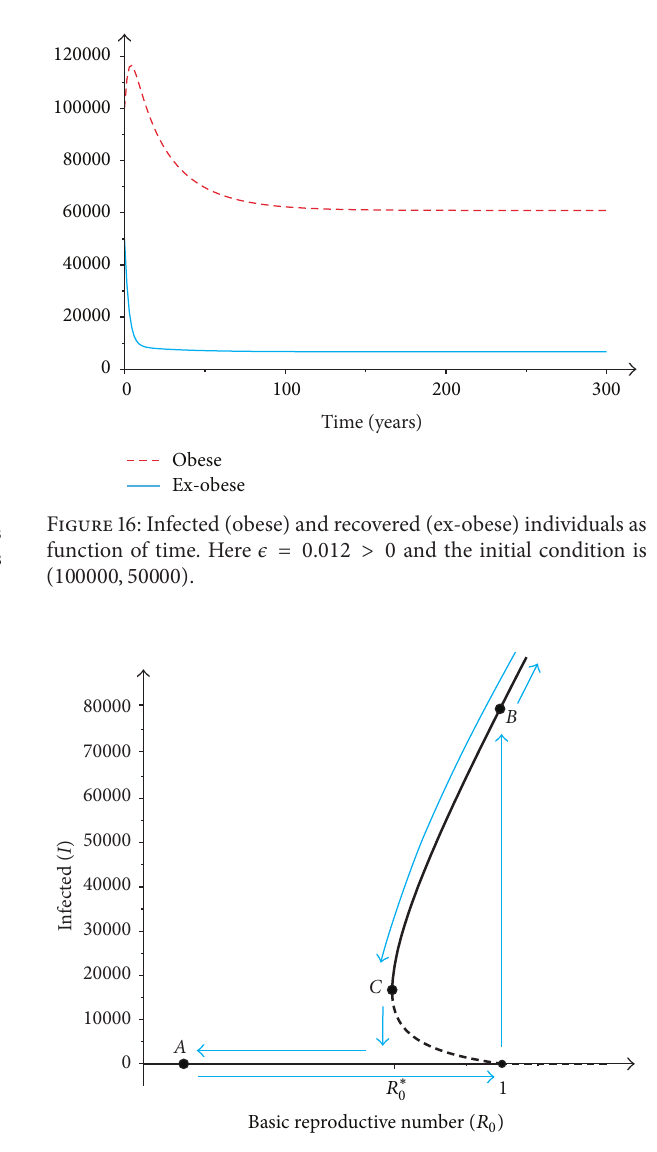
Figure 17: Schematic representation of hysteresis phenomenon that exhibits the bifurcation diagram of system (4) for the case 𝜖 = 0 . Here the forward and backward paths are not equal as the parameter 𝑅 0 is